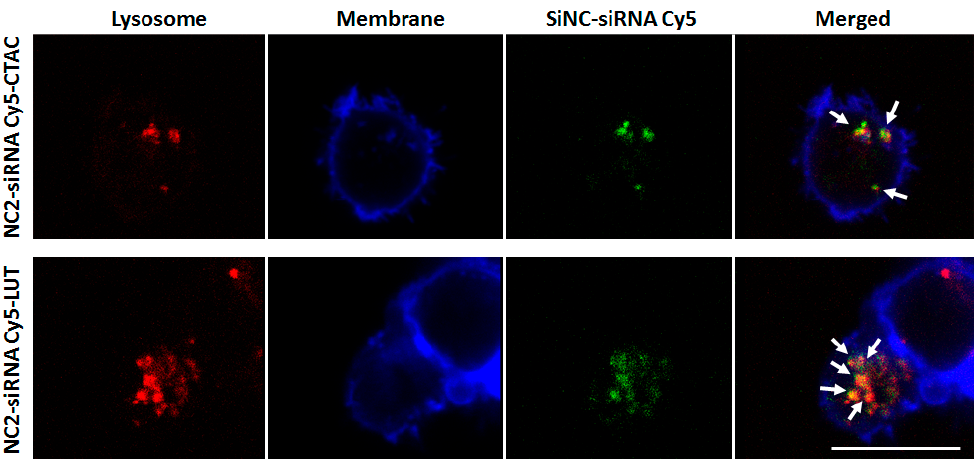
Figure 3. cLSM images of SiNCs-encapsulated siRNA Cy5, co-localized with lysosomes in CD8 + T-cells after 17 h. A co-localization assay was performed by staining lysosomes with LysoTracker dye (red). The membrane was stained with CellMask™Orange (blue). The SiNC was labeled with siRNA Cy5 (green). The merged images demonstrated that the SiNCs encapsulated siRNA Cy5 were co-localized with lysosomes, as indicated by the white arrows. The scale bars represent 10 µm.